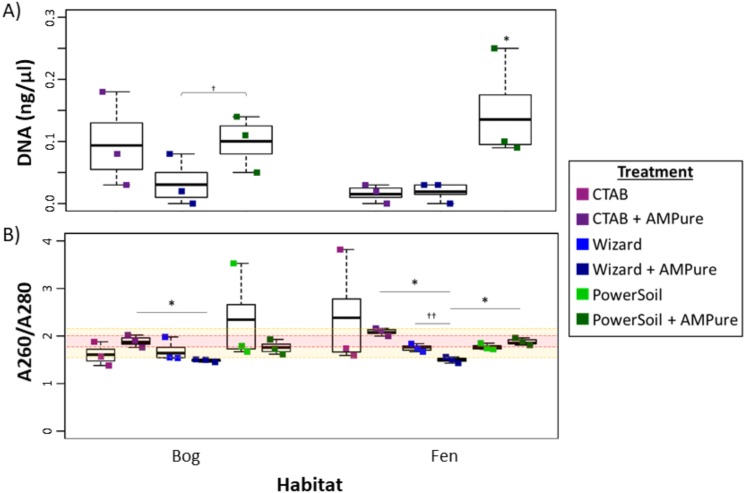
Impact of extraction methods on DNA yields and purity (Experiment 1).Bog samples are shown on the left of each panel, fen samples on the right. DNA extraction methods are color-coded: purple for CTAB, blue for Wizard, and green for PowerSoil. * denotes significant difference via one-way ANOVA, α 0.05, and Tukey’s test with p-value < 0.05. † denotes significant difference for t test, p-value < 0.05; †† = p-value <0.01; ††† = p-value <0.001. (A)The DNA concentration (ng/µl) after AMPure purification for the three DNA extraction methods. (B) DNA extract purity via A260/A280. Dotted lines are purity thresholds: Acceptable range in yellow shading and preferred range in red shading.